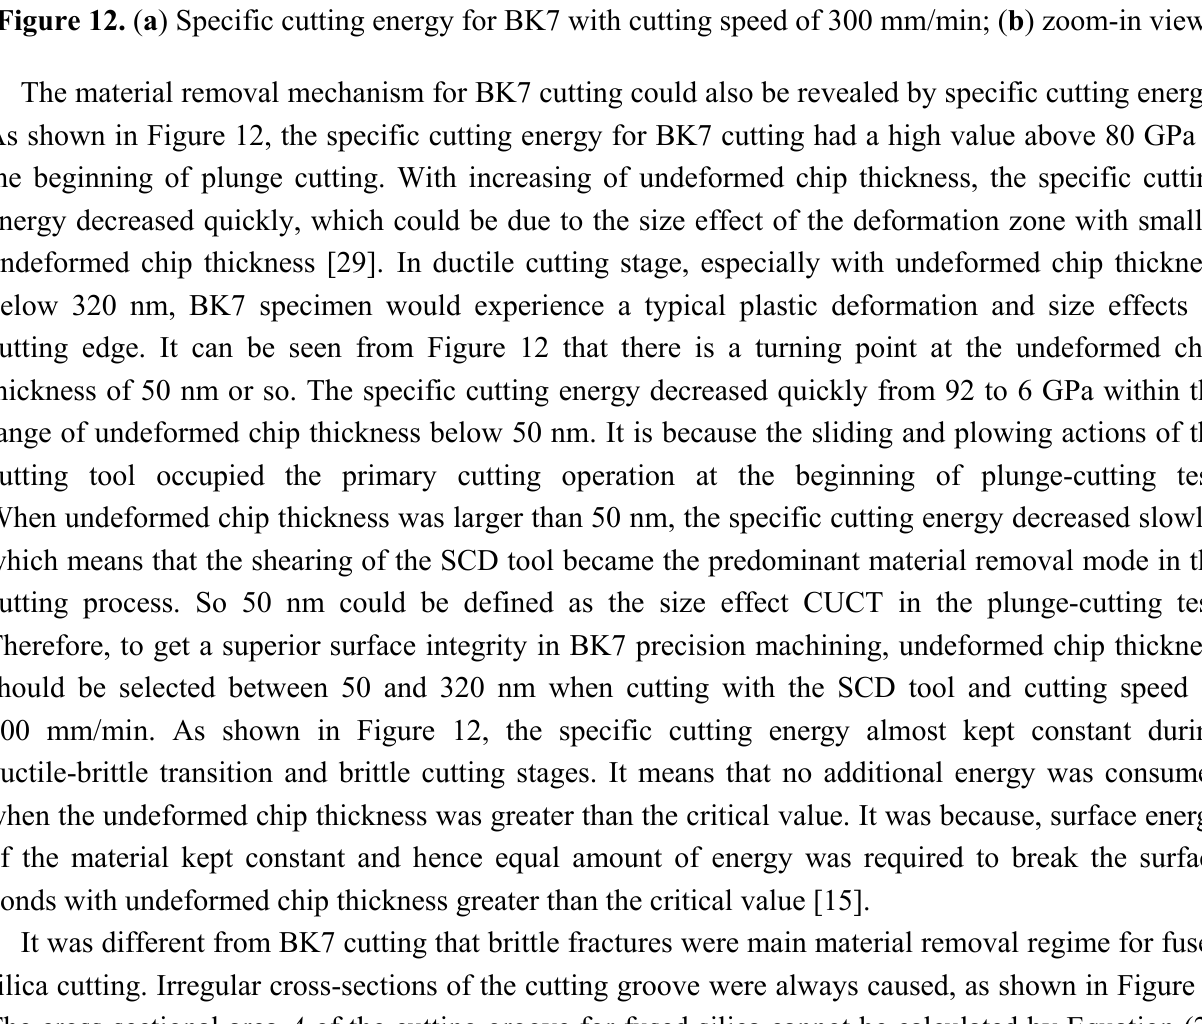
Figure 12. ( a ) Specific cutting energy for BK7 with cutting speed of 300 mm/min; ( b ) zoom-in